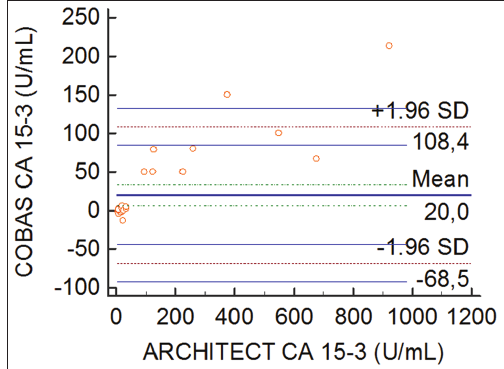
FIGURE 4. Comparison of two methods, ARCHITECT i2000SR and cobas e 601, for detection of cancer antigen (CA) 15-3. The bias (mean difference) is 20 U/mL; 95% confidence interval [CI], –68.5 to 108.4 U/mL.